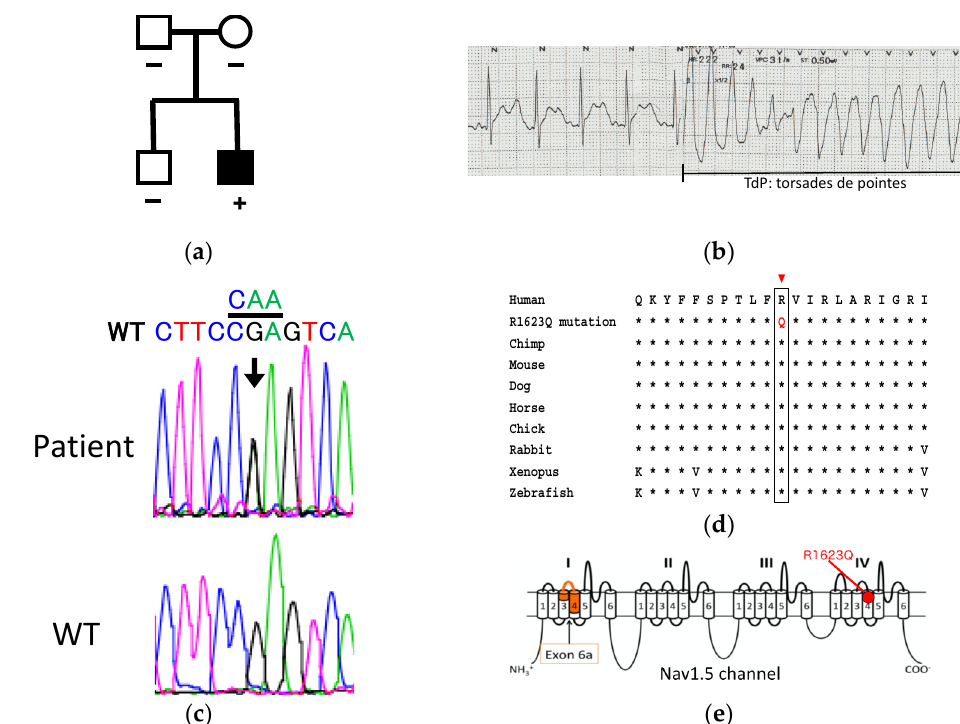
Figure 1. Clinical summary of the patient harboring Nav1.5 R1623Q mutation. ( a ) Pedigree of the family. ( b ) Baseline ECG of the index patient when he had VT storm at age of 2 years. QTc 540 ms was diagnosed at this time. ( c ) Sequence analysis of SCN5A identified the R1623Q heterozygous point mutation in the patient genome. ( d ) Multiple amino acid-sequence alignments of Nav1.5 regions bearing the R1623Q mutation with corresponding Nav1.5 amino acid sequences of different species. ( e ) Membrane-spanning model of the Nav1.5 channel indicating the locations of exon 6a and R1623Q mutation.